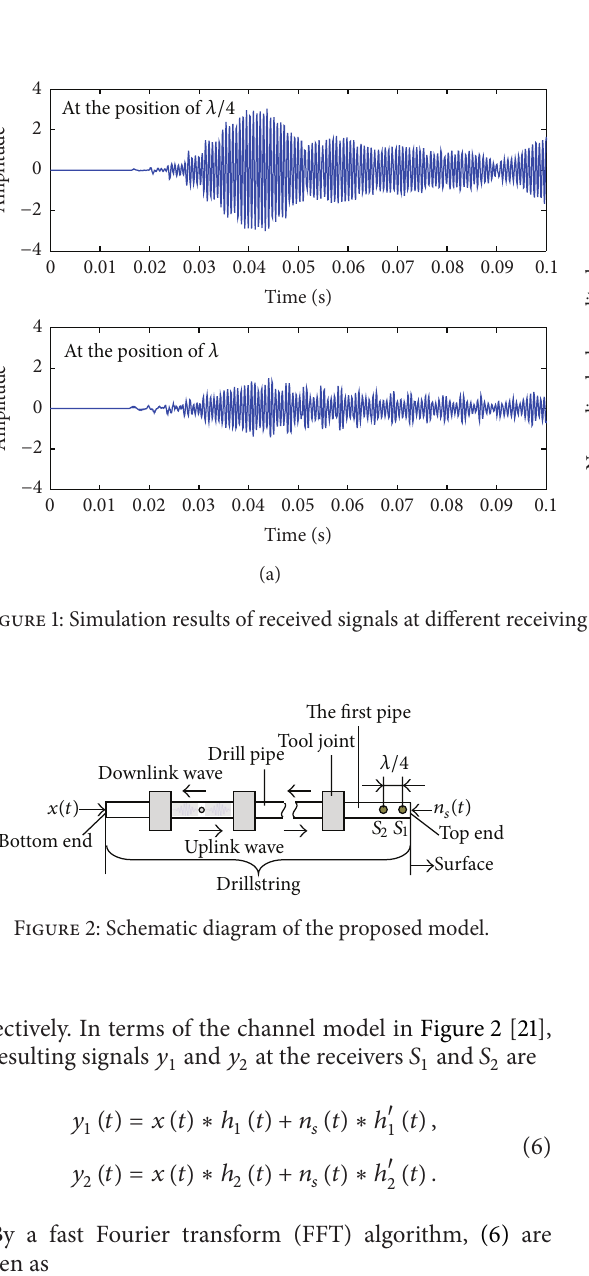
respectively. In terms of the channel model in Figure 2